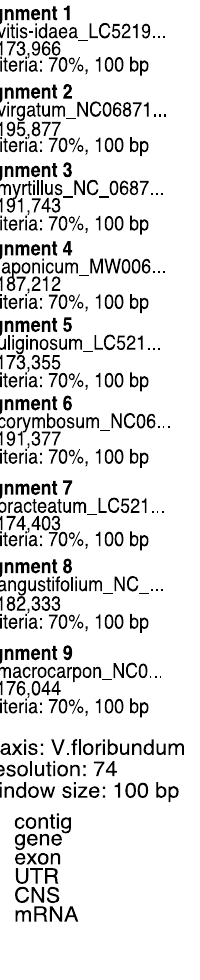
Figure 4. mVISTA cp genome alignments of V. floribundum and the other nine Vaccinium species. The x-axis corresponds to the coordinates of the V. floribundum cp genome used as a reference. The y-axis (horizontal bars) represents the percent identity (50–100%) across regions in each of the analyzed Vaccinium species. Dissimilar regions are in white. Annotated genes appear at the top.